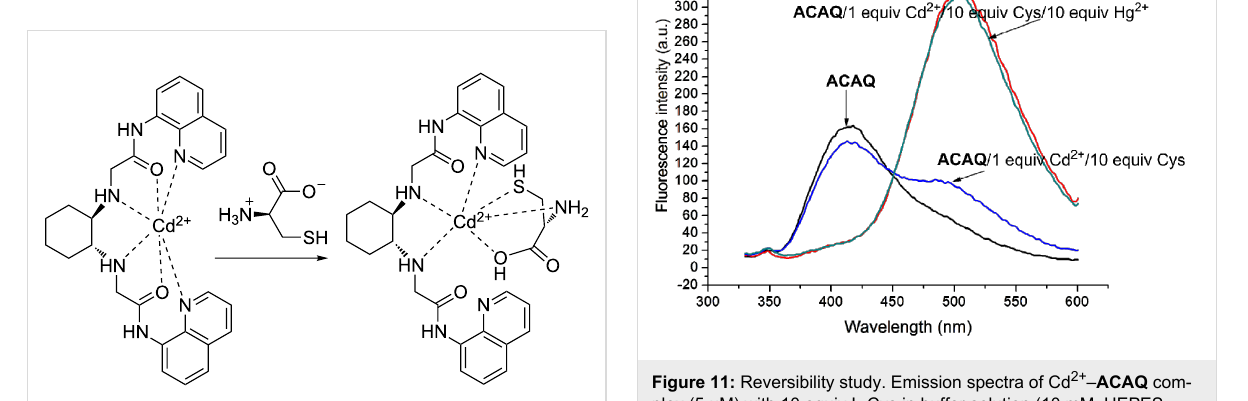
Figure 11: Reversibility study. Emission spectra of Cd 2+ – ACAQ com- plex (5 μ M) with 10 equiv L-Cys in buffer solution (10 mM, HEPES, 80% ACN, pH 7.4) at 298 K, then 10 equiv of Hg 2+ . Excitation wave- length was 315 nm.